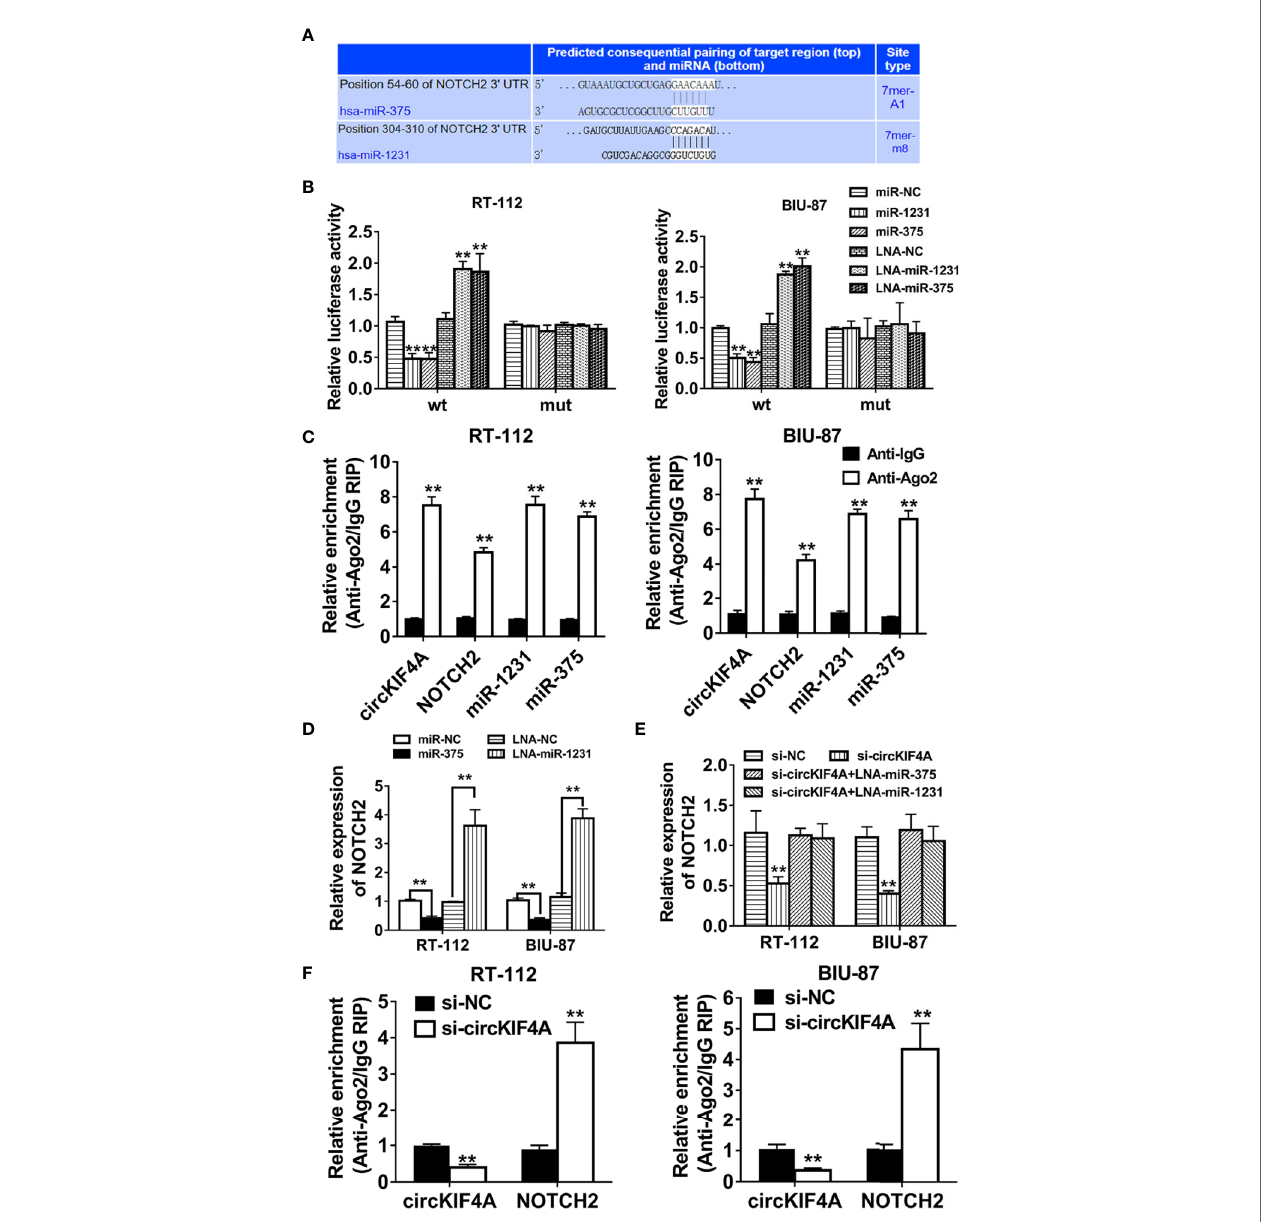
FIGURE 4 | NOTCH2 is the co-target of miR-375 and miR-1231. (A) Predicted binding sites of miR-375 and miR-1231 in the 3 ′ -UTR of NOTCH2 according to the TargetScan algorithm (http://www.targetscan.org). (B) Luciferase reporter assays were conducted. RT-112 and BIU-87 cells were cotransfected with miR-375/1231 mimics, locked nucleic acid (LNA) and circKIF4A wild type or mutant luciferase reporter. (C) Enrichment of circKIF4A, NOTCH2, miR-375 and miR-1231 with Ago2 assessed by RIP assay. (D) The expression level of NOTCH2 was decreased after transfection with miR-375/1231 mimics. The expression of NOTCH2 was increased after knockdown of miR-375/1231. (E) In fl uence of circKIF4A on the expression of NOTCH2 detected by qRT-PCR analysis. (F) Enrichment of Ago2 for circKIF4A was decreased, while NOTCH2 was increased after knockdown of circKIF4A. **P <